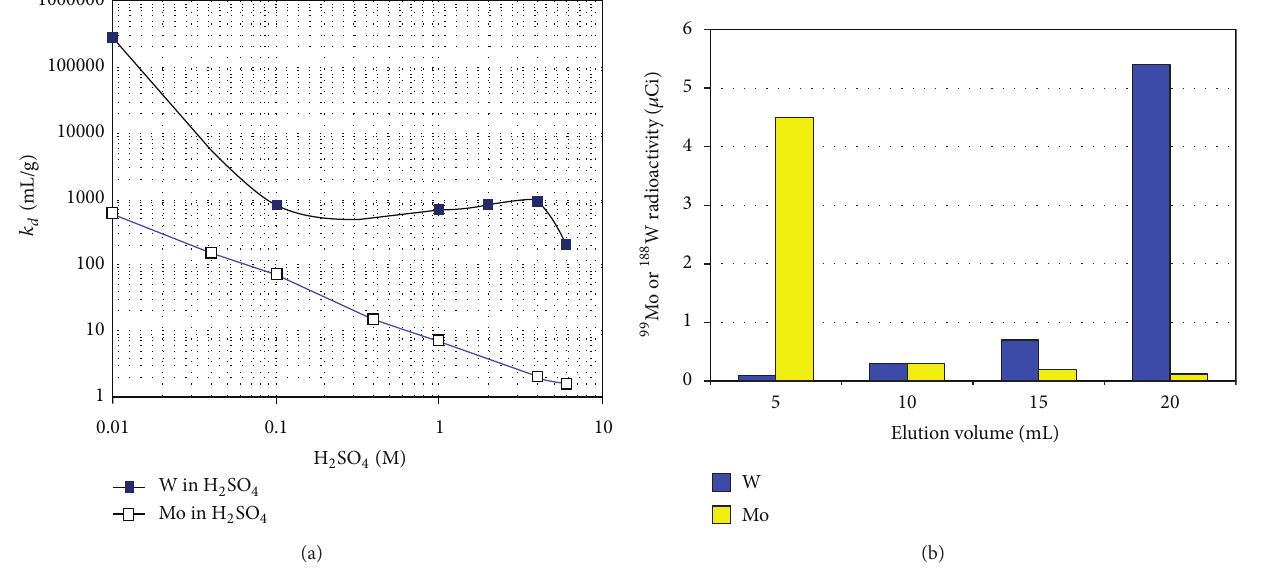
Figure2:W/Moadsorptionandseparationusingaluminacolumn:(a)weightdistributioncoefficientsofWO 42− andMoO 42− ionsonalumina versus acidity of H 2 SO 4 solution; (b) elution profile of WO 42− and MoO 42− ions (column: 1g alumina; eluent: 6 M H 2 SO 4 for MoO 42− elution and 1M NH 4 OH for WO 42− stripping; loading solution: 8 mg Mo + 10mg W)